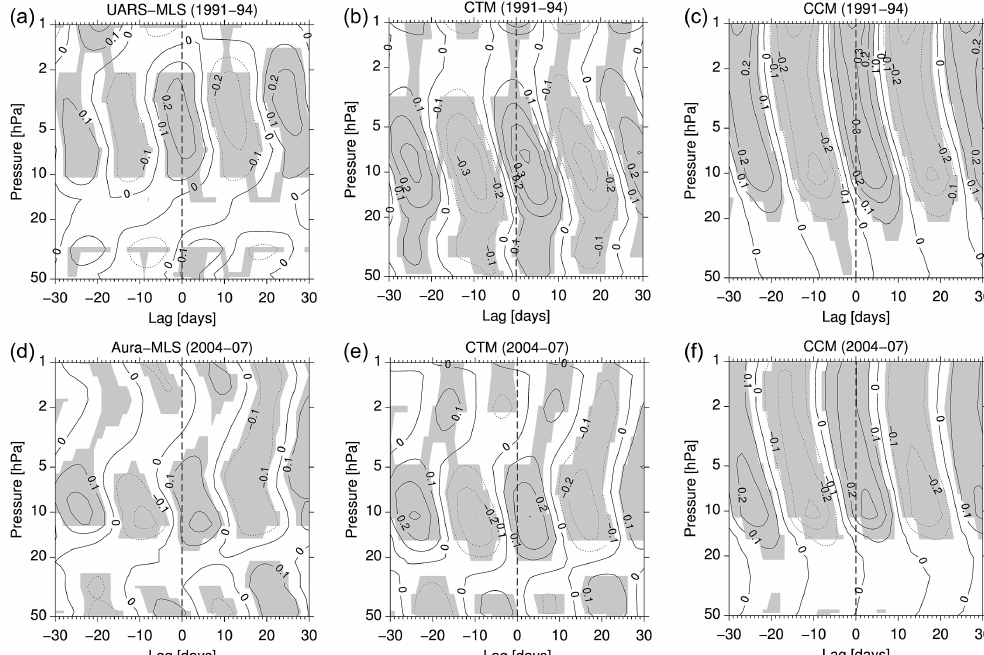
Figure 6. Cross-correlation between digitally filtered (see main text) ozone and F205 as a function of time lag (in days) and pressure level (hPa) for the (a, b, c) 1991–1994 and (d, e, f) 2004–2007 periods. Panels (a, d) , (b, e) and (c, f) show cross-correlation between F205 and MLS observations, CTM and CCM simulations, respectively. Shading represents areas with 95% confidence